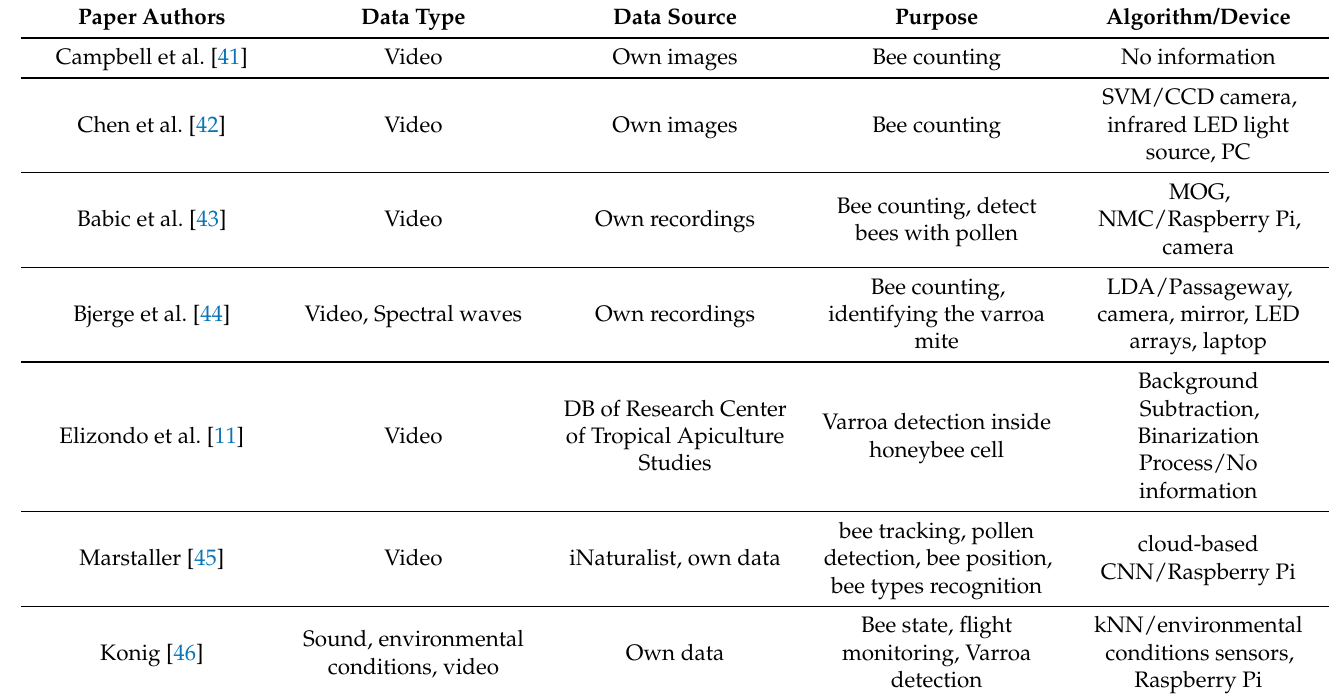
Table 1. Comparison of bee monitoring